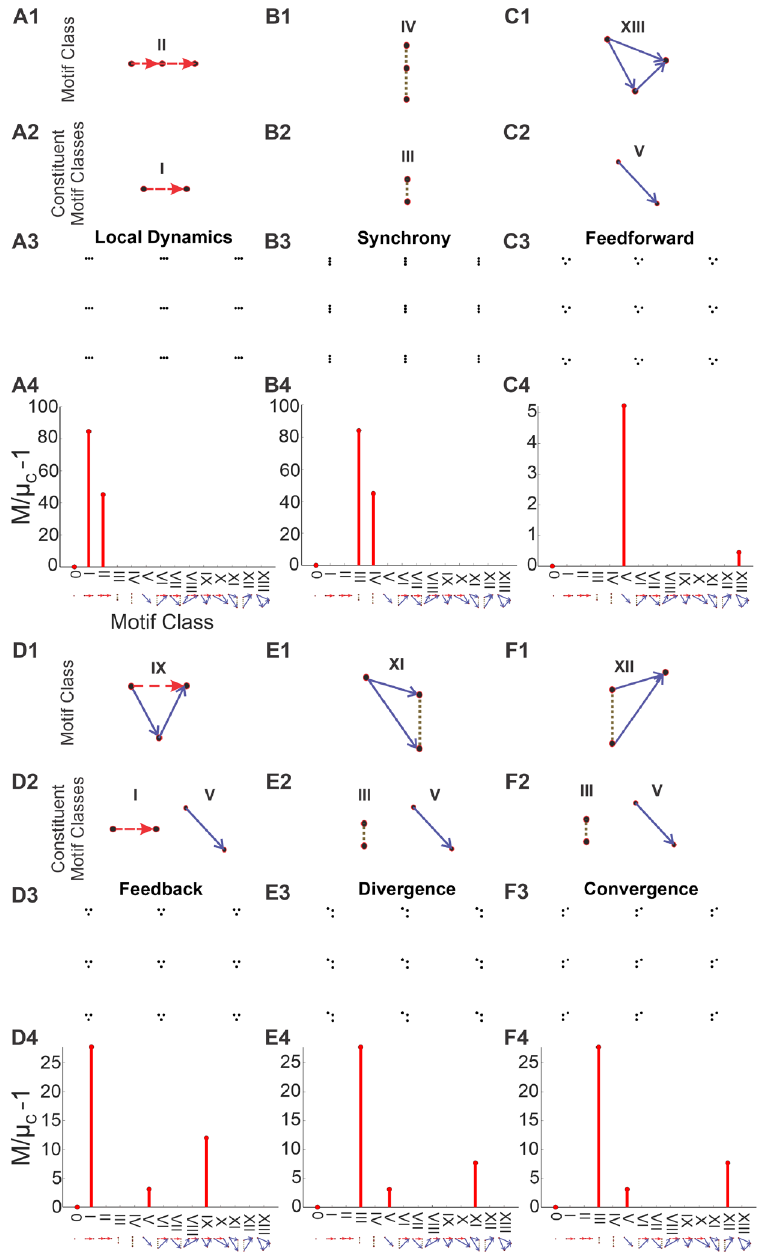
Figure 4. Detecting motif classes in individual patterns. We simulated 150 × 150 rasters, each consisting of a single repeated triplet. Row 1 : the motif class of the repeated triplet. Row 2 : the motif class’ constituent motif classes. Row 3 : the simulated raster. Row 4 : the motif-class contributions ( M /µ c − 1 ) calculated from the row 3 raster’s triple correlation, using lags of up to 14 bins (which is less than the separation between motifs in the raster). In all cases, the highest-order motif with a non-zero contribution is the motif class, and the remaining non-zero contributions are the constituent motif classes. Note the changing y-axis scale: motif classes I and III are far less likely to occur from chance than motif class